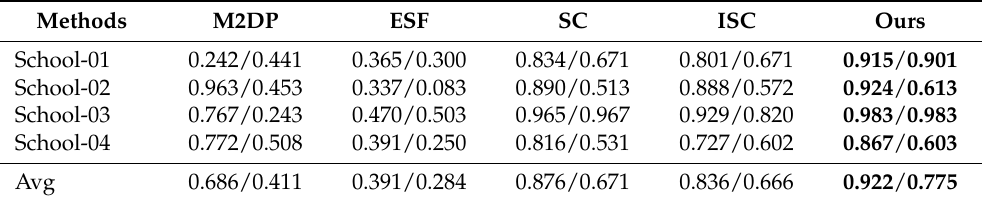
Table 2. F1 max scores and EP on School